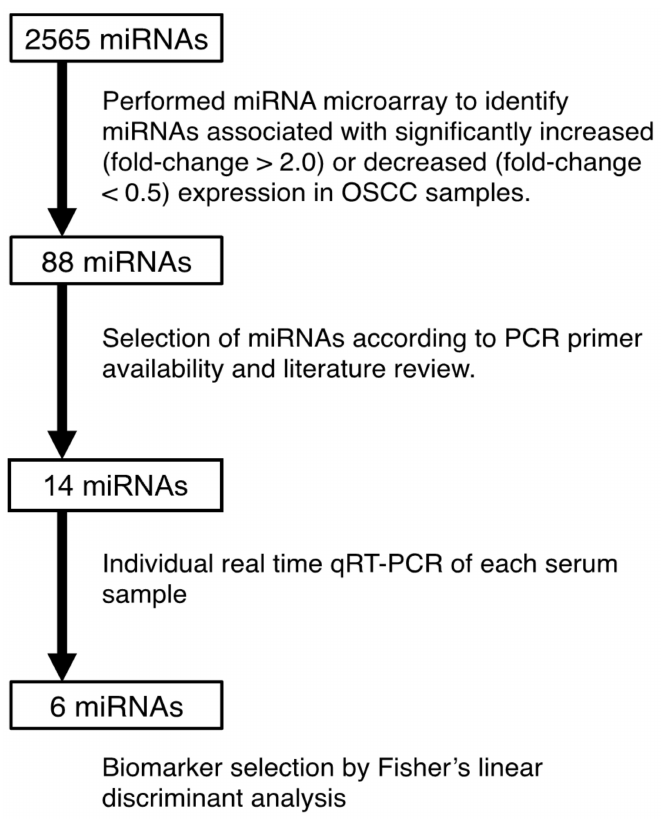
Figure 2. Flow diagram for detection of candidate